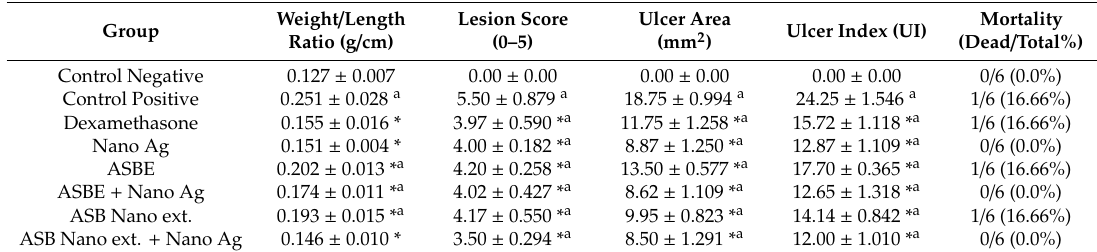
Table 1. E ff ect of ASBE, nano-extracts, and their combination with nano-Ag on the macroscopic parameters of ulcerative